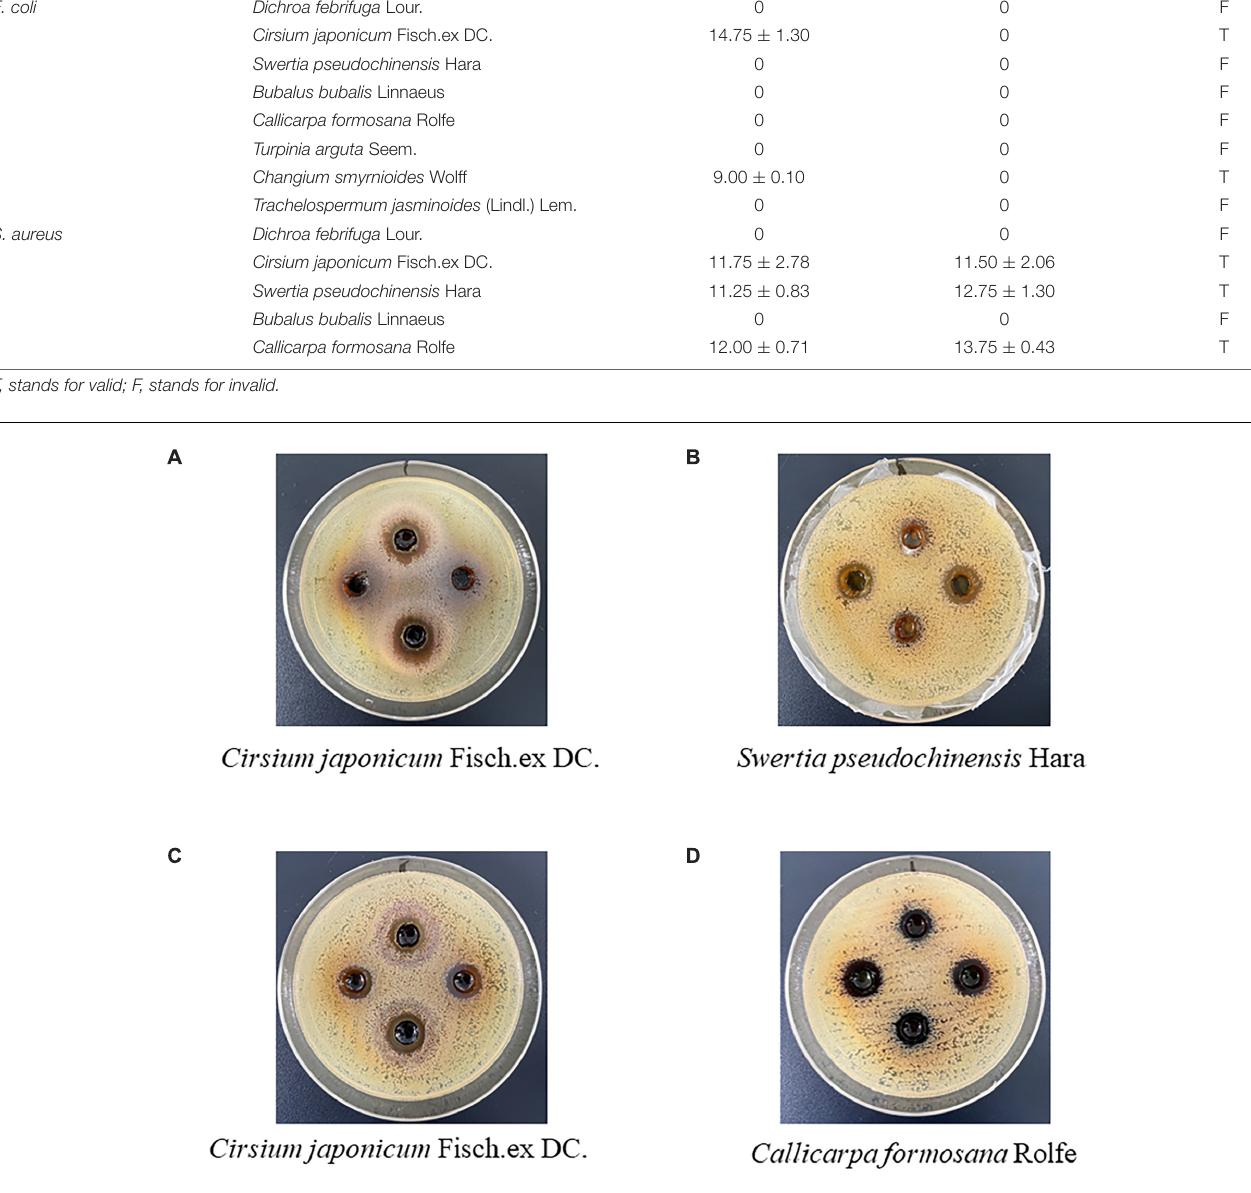
agreement with the experiment. The prediction accuracy was 60% ( Table 4